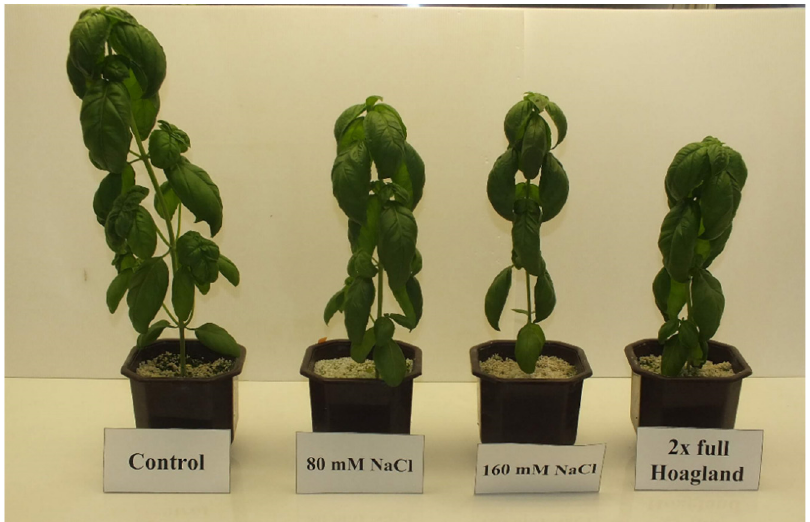
Figure 3. Basil plants at the end of the experiment.